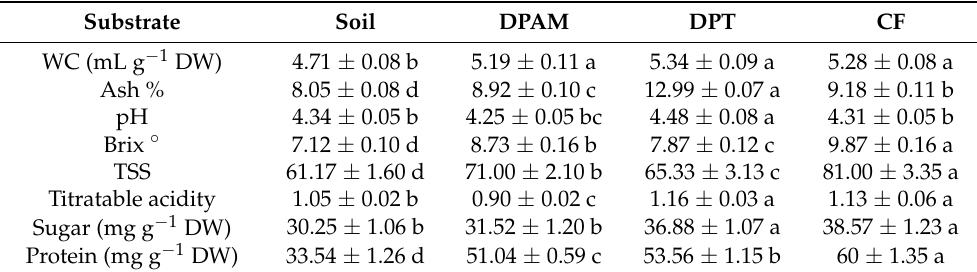
Results representthe mean of triplicate determinations ± S.D. Numbers followed by a different letter within a line are significantly different at p ≤ 0.05, according to LSD analysis.